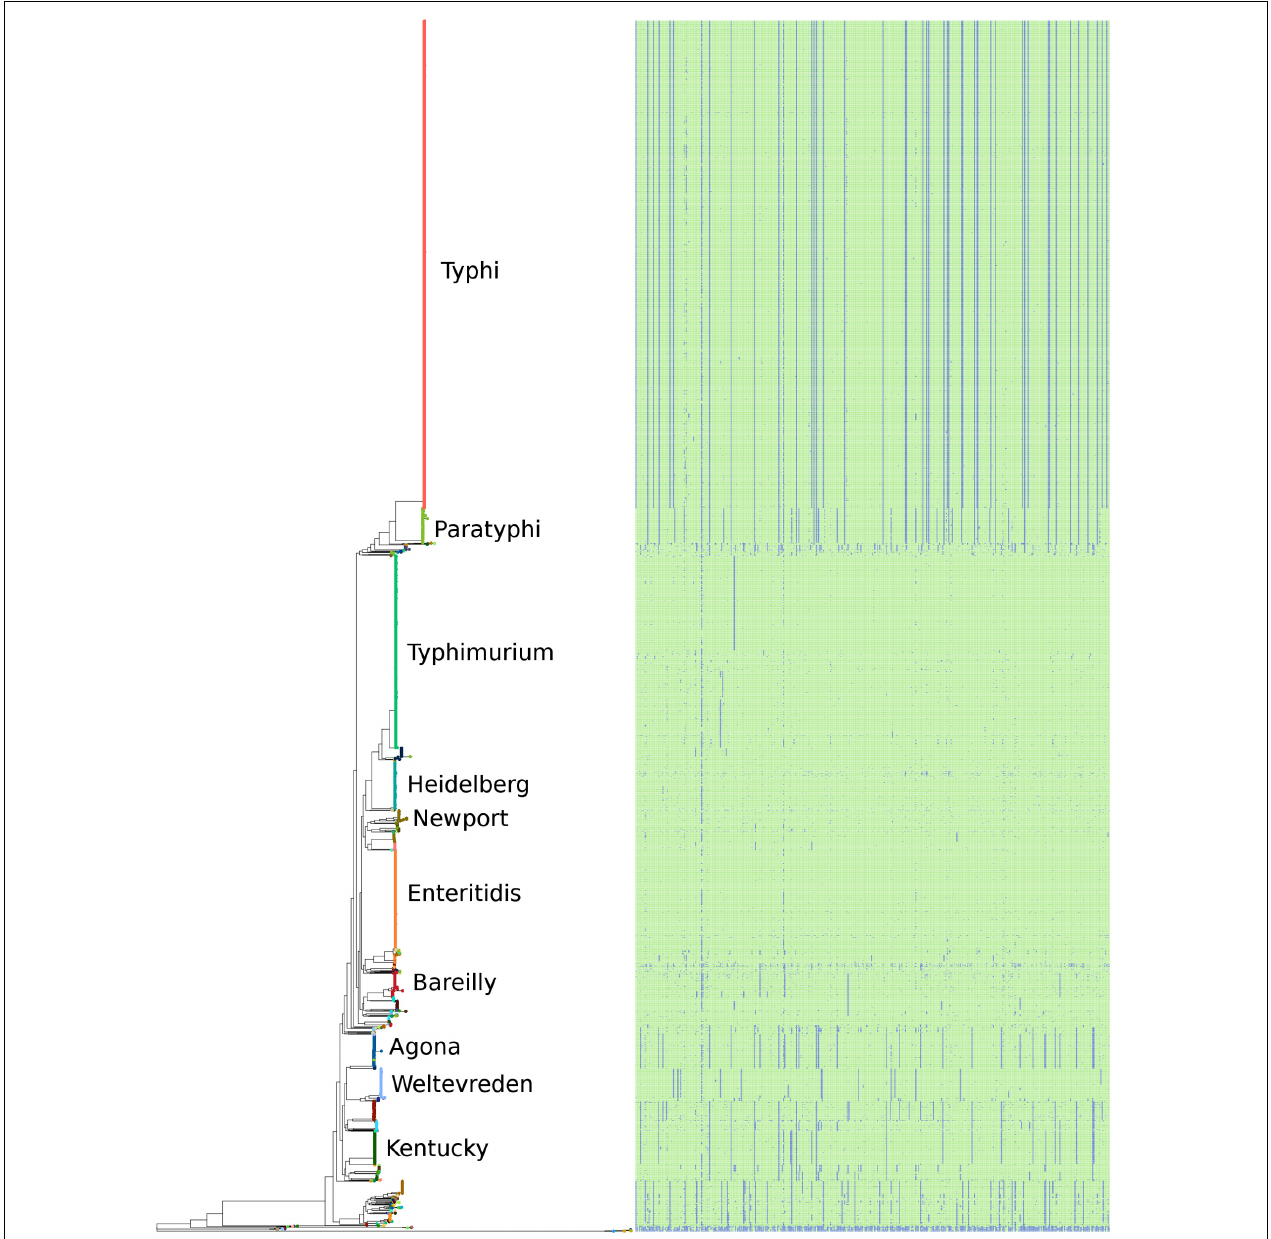
FIGURE 5 | The phylogeny of the 4893 S. enterica genomes post quality-filtering based on SNPs found within the conserved core genome. The 10 most abundant serovars of subspecies enterica in the current study (Agona, Bareilly, Enteritidis, Heidelberg, Kentucky, Newport, Paratyphi, Typhi, Typhimurium, Weltevreden) are labeled on the tree. The matrix to the right of the phylogeny represents the 404 species-specific regions, with blue being the absence of a region, and green being the presence of a region, for each of the genomes of the